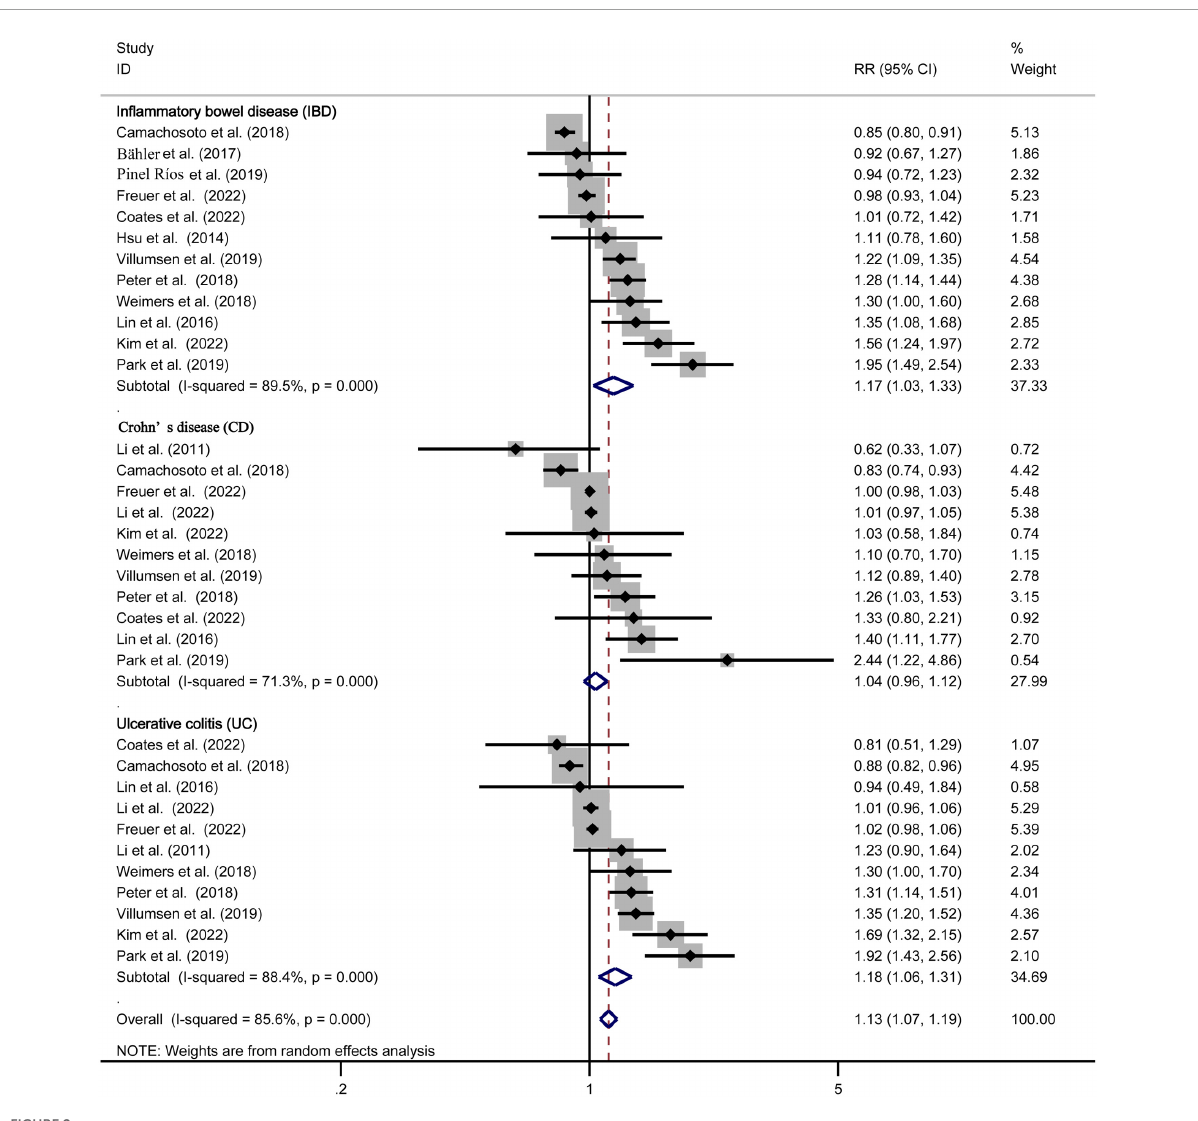
0.95, 1.14) ( Figure 3 ). The Begg’s funnel plot and